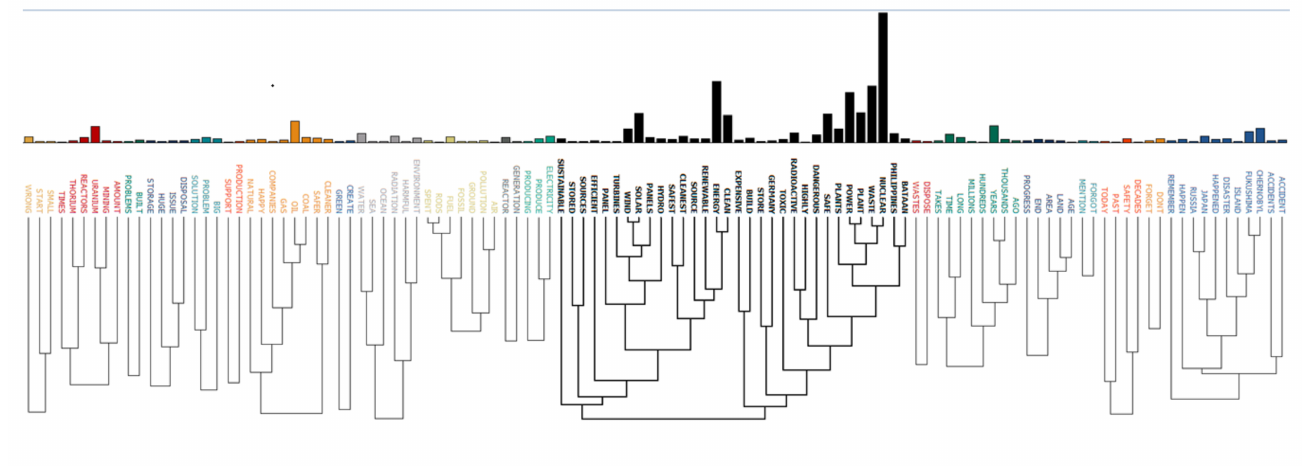
Figure A2. Hierarchical analysis applied to the comments on the ‘NAS daily’ post